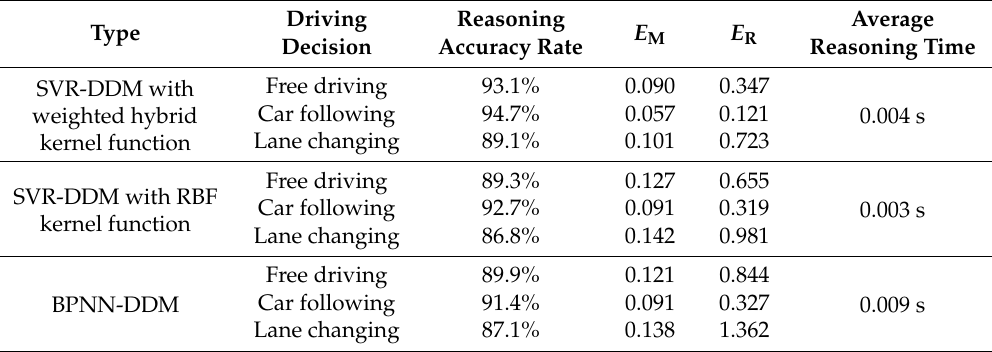
Table 4. The reasoning results of three driving decision-making mechanism (DDMs). SVR: Support Vector Machine Regression; RBF: Radial Basis Function; BPNN: Back Propagation neural